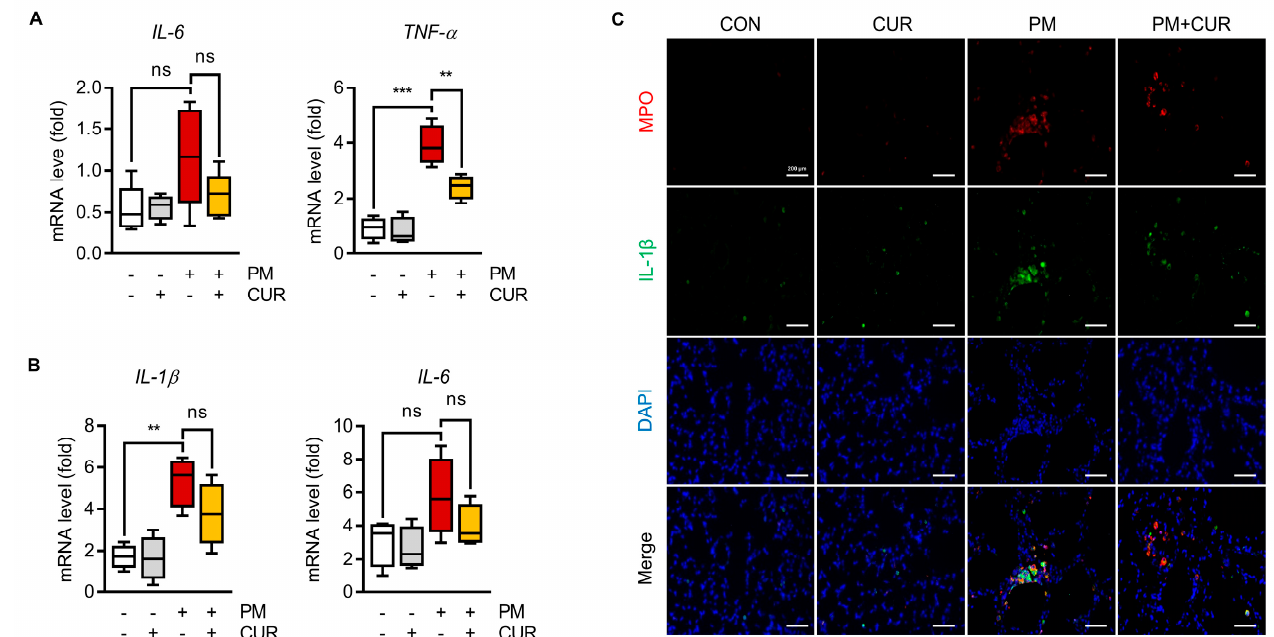
Figure 2. Curcumin downregulated the expression of IL-1 β , IL-6, and TNF- α in PM-induced in- flammation in mice lung tissue and BALF. ( A ) Effect of curcumin on PM-induced inflammatory cytokine production in lung tissue determined by RT-qPCR. ( B ) Effect of curcumin on PM-induced inflammatory cytokine production in BALF. ( C ) Co-localization of IL-1 β with MPO was observed after immunofluorescence staining using indicated antibodies. Scale bars indicate 200 µ m. ** p < 0.01, *** p < 0.005, and ns (not significant) indicates p ≥ 0.05 vs. PM-treated group. CON, control group; CUR, curcumin; PM, particulate matter (n = 6 per group).